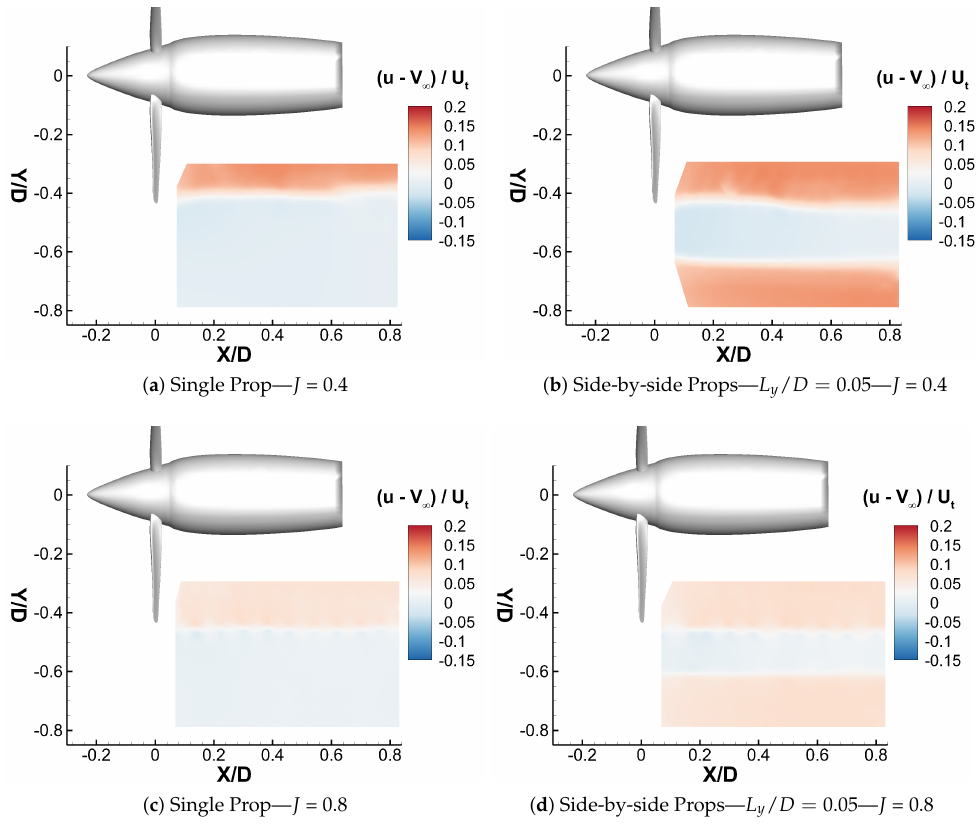
Figure 7. Comparison of the ensemble-averaged non-dimensional free-stream velocity component contours at Re D = 1.96 × 10 6 and M t =